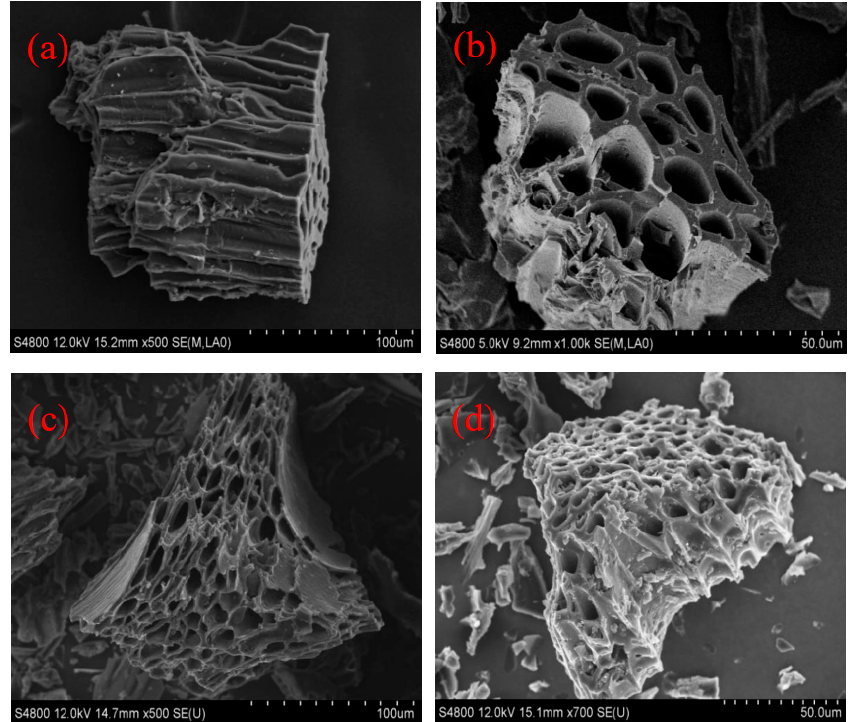
Figure 1. SEM images of the sawdust-derived biochar (BC) ( a , b ) and acid-modified biochar (ABC) ( c , d ).